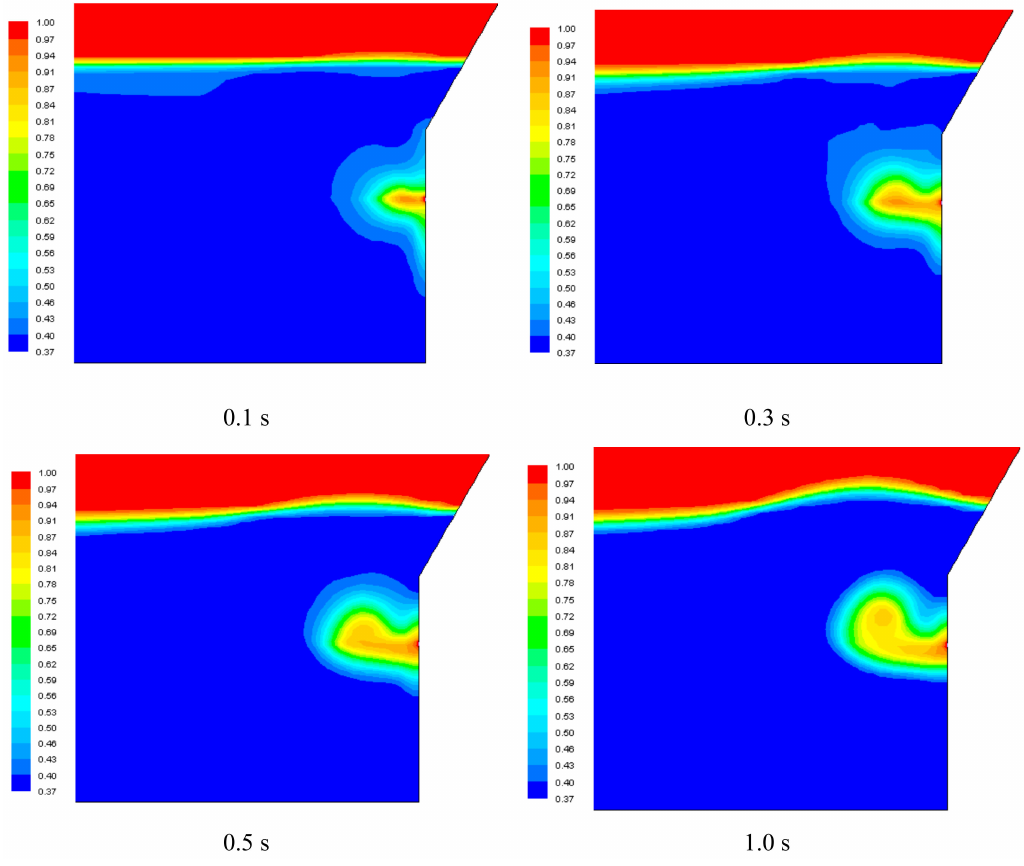
Figure 3. Variation of gas phase volume fraction with time.